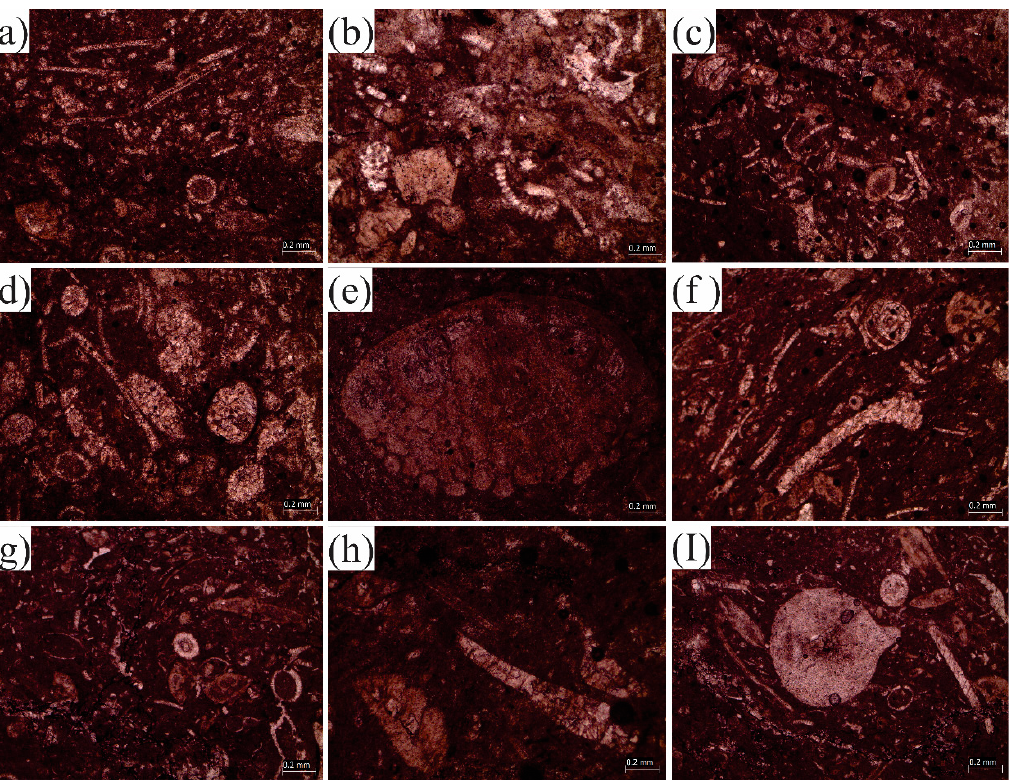
Figure 6. Photomicrographs showing ( a ) phylloid, dascycladacean and calcispheres algae; ( b ) mixed red and green algae; ( c ) Gymnocodiacea; ( d ) holothurian spicules (ossicles) and Idalina grelaudae (Middle Eocene milliolid); ( e ) Lockhartia praehaimei ; ( f ) ostracod and green algae; ( g ) phylloid and gymnocodiacea green algae; ( h ) Pellatispira spp. and phylloid algae; and ( I ) Saccammina grzybowskii (Eocene foram). Table 3. An average mineralogical composition of the Early–Middle Eocene carbonate microfacies of Yadgaar